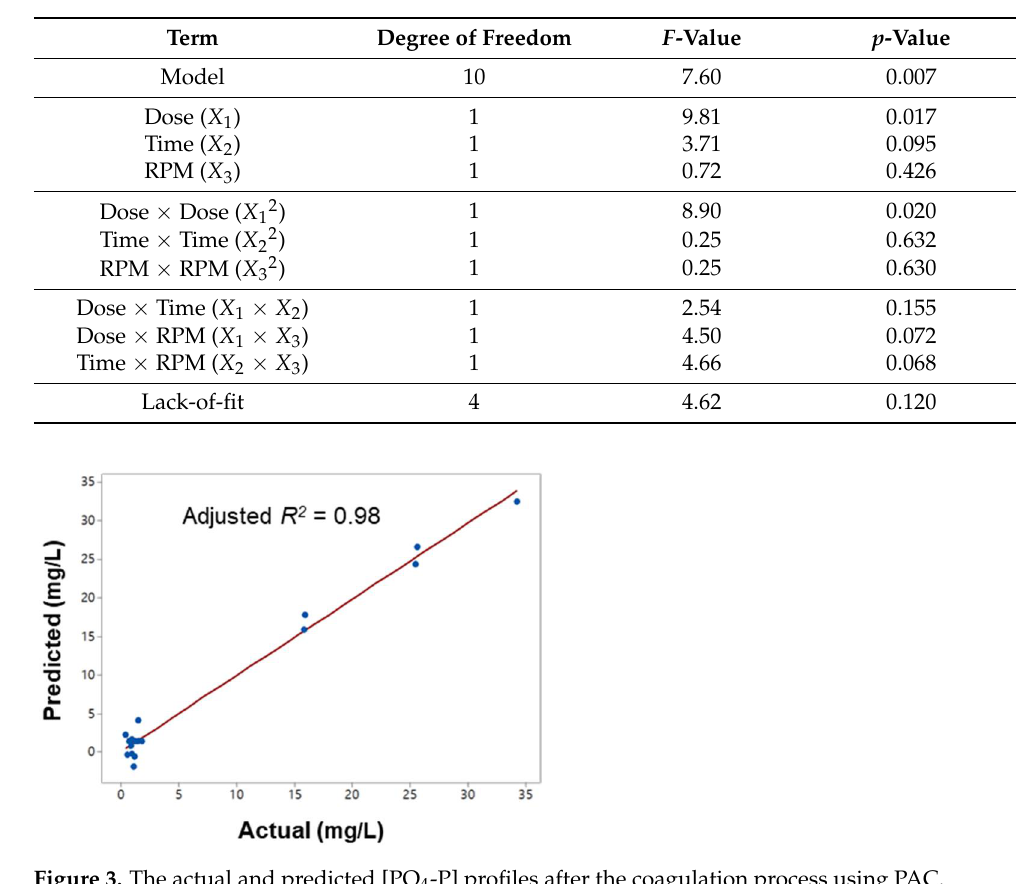
Table 4. The ANOVA results of the quadratic model for PAC derived from RSM.